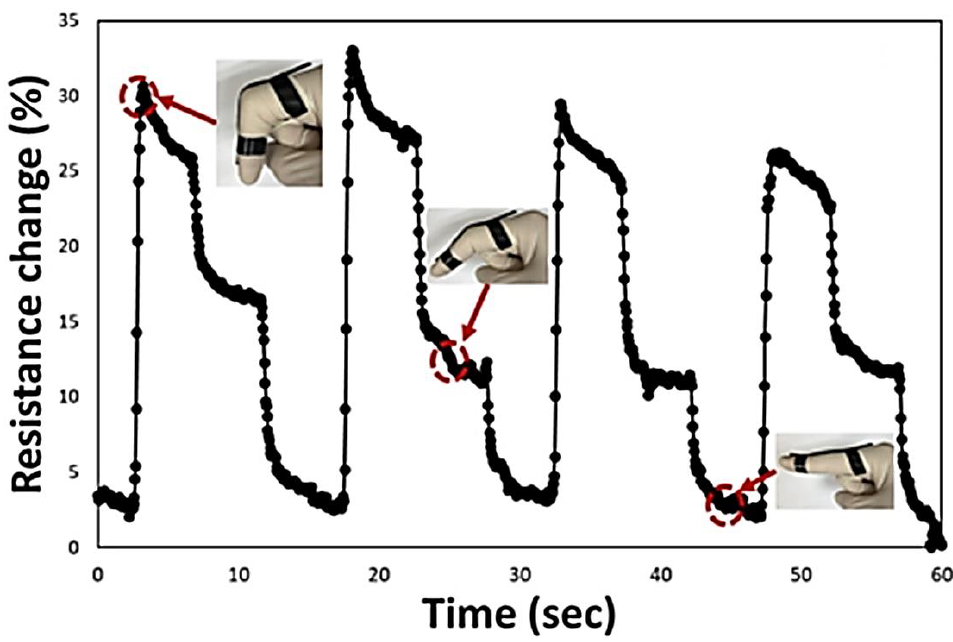
Figure 13. Responses of fabricated sensors during the monitoring of finger gestures in real time for CNT ‐ CIP ‐ based composites [52]. CNT-CIP-based composites [52].